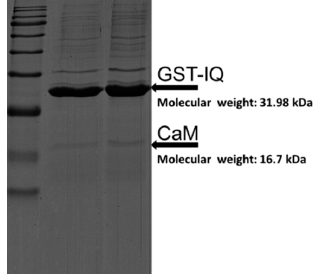
Figure 1. The binding of calmodulin (CaM) on GST-IQ of Na V 1.1 with marker on the left side. The molecular weight of CaM and GST-IQ is 16.7 kDa and 31.98 kDa, respectively.